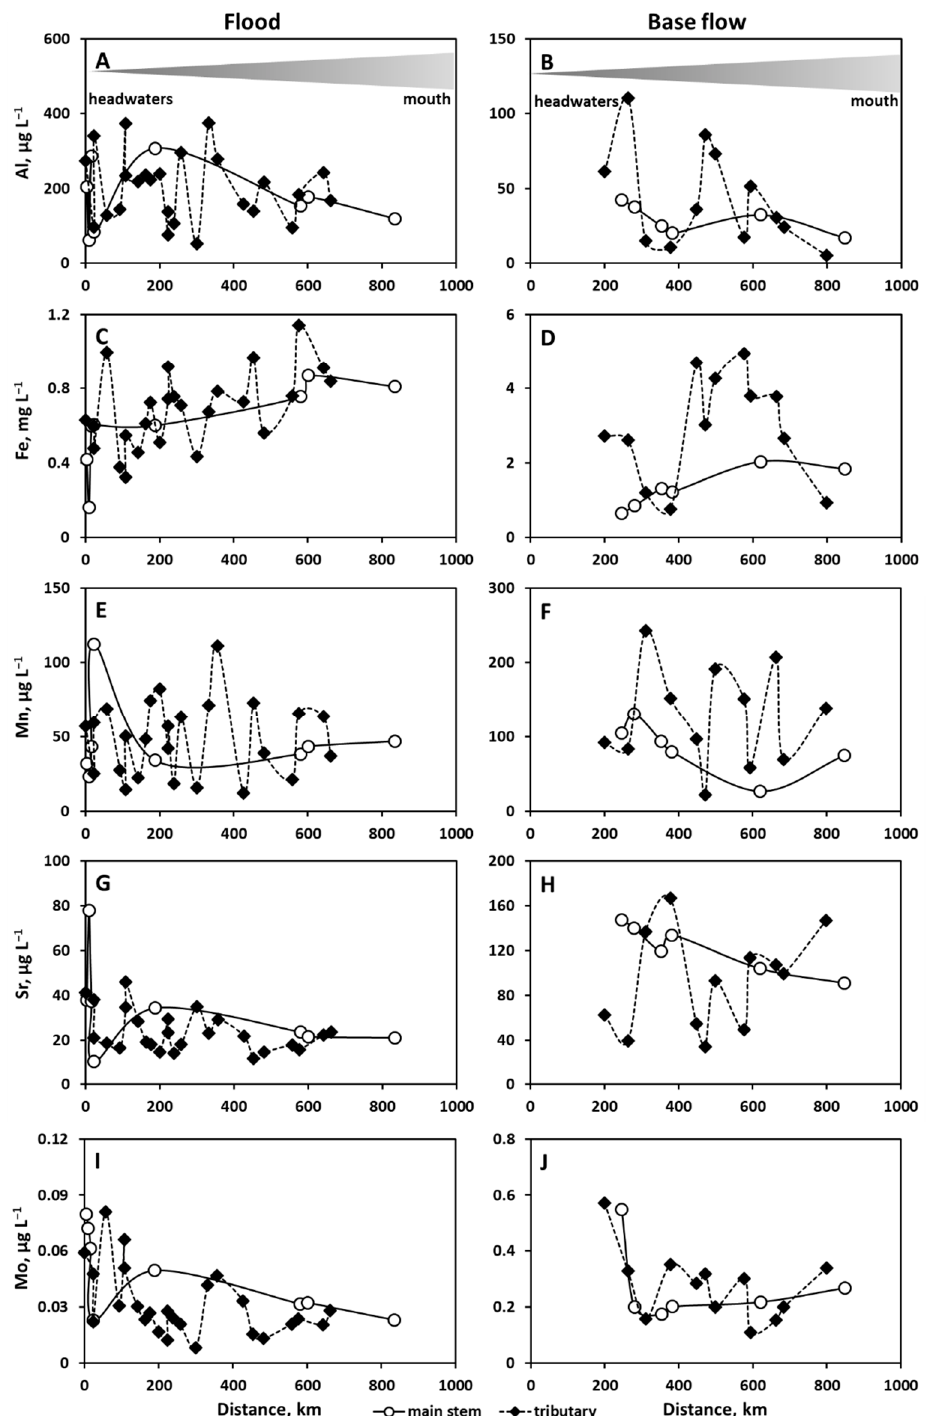
Figure 3. Al ( A , B ), Fe ( C , D ), Mn ( E , F ), Sr ( G , H ) and Mo ( I , G ) concentration in the Ket River main stem (open circles) and tributaries (solid diamonds) during spring flood ( A , C , E , G , I ) and summer baseflow ( B , D , F , H , J ).